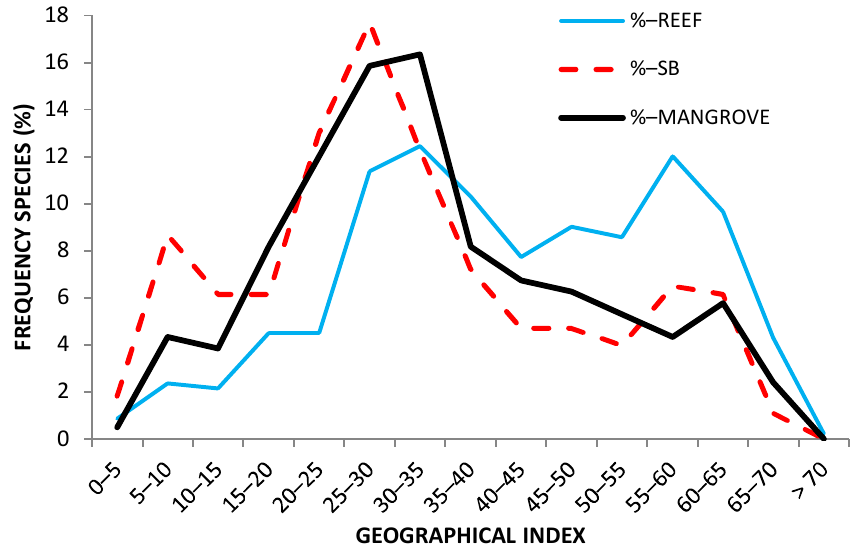
Figure 6. Distribution of the geographical index according to habitat. SB: soft-bottom.